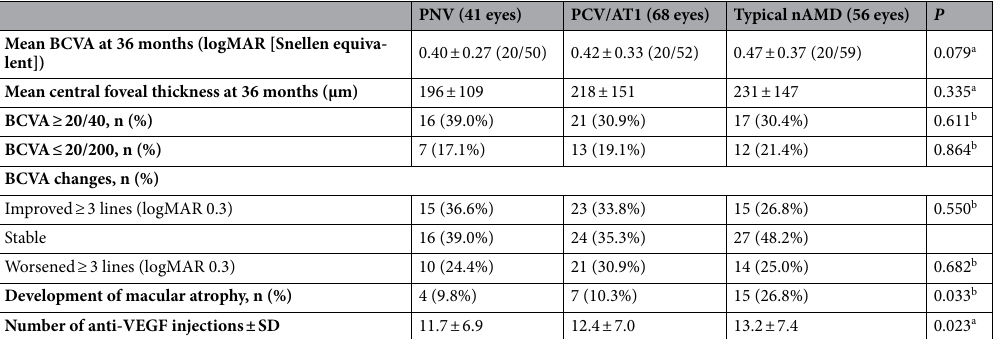
Table 2. Three-year results of the treatment with anti-VEGF for macular neovascularization. a Based on one- way analysis of variance. b Based on chi-square test. BCVA best-corrected visual acuity, logMAR logarithm of the minimum angle of resolution, nAMD neovascular age-related macular degeneration, PCV/AT1 polypoidal choroidal vasculopathy/aneurysmal type 1 neovascularization, PNV pachychoroid neovasculopathy, SD standard deviation, VEGF vascular endothelial growth